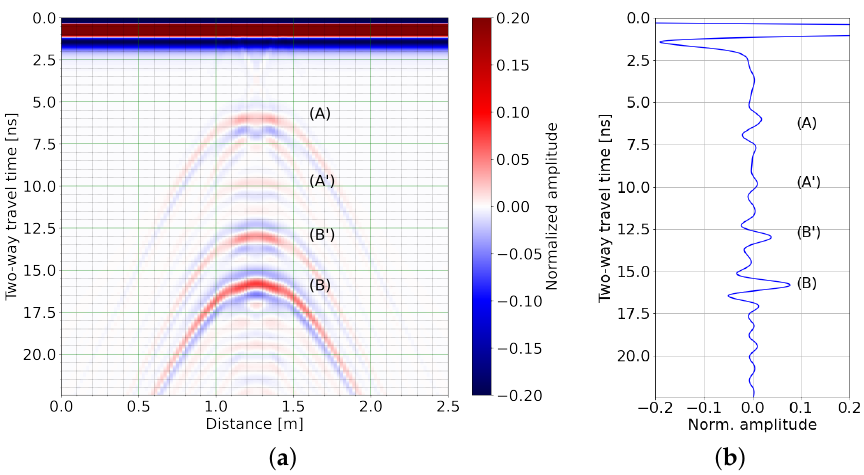
Figure 8. ( a ) Radargram obtained using a 500 MHz Ricker source for the geometry of Figure 7; (A)–(B’) reflections are described in the text. ( b ) Trace simulated at 1.25 m from the beginning of the profile (see correspondence in ( a )).